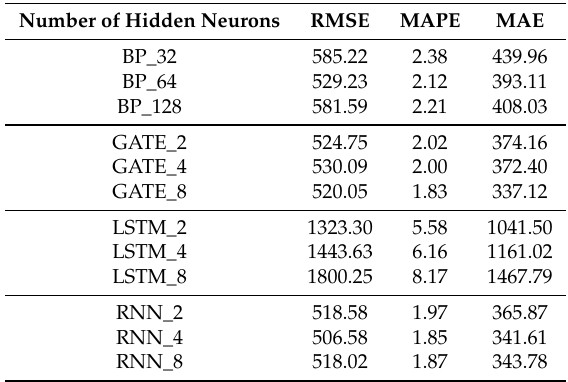
Table 2. Results of different hidden layer sizes in 30-min time scale test